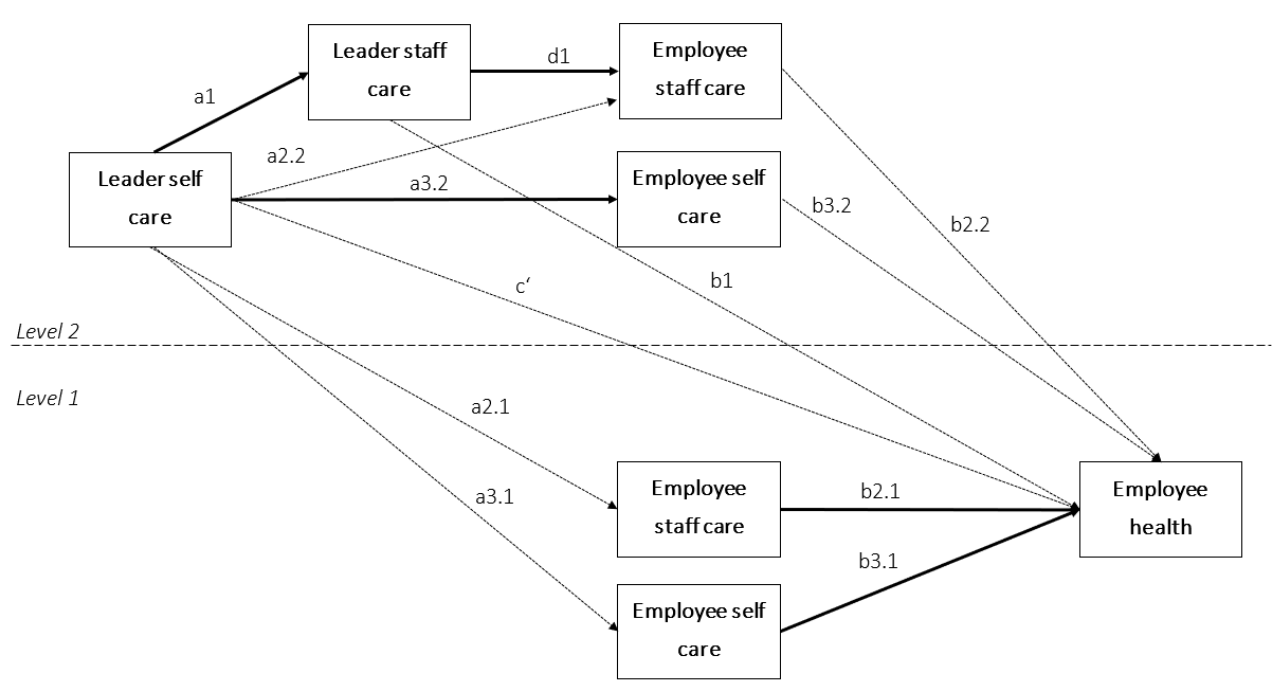
Figure 1. Conceptual model of the hypothesized mediation models from leader self-care ( X j for a given team) to employee health ( Y 2 ij ) (a) via leader staff care ( M 1 j for a given team) and employee staff care ( M ̅ 2 j for a given team and M 2 ij for a given employee; within-team indirect effect: a1*d1*b2.1), and (b) via employee self-care ( M ̅ 3 j for a given team and M 3 ij for a given employee; indirect effect: a3.2*b3.1). The paths a2.1 and a2.2, and a3.1 and a3.2, are assumed to be equal; paths relevant to the hypotheses are in